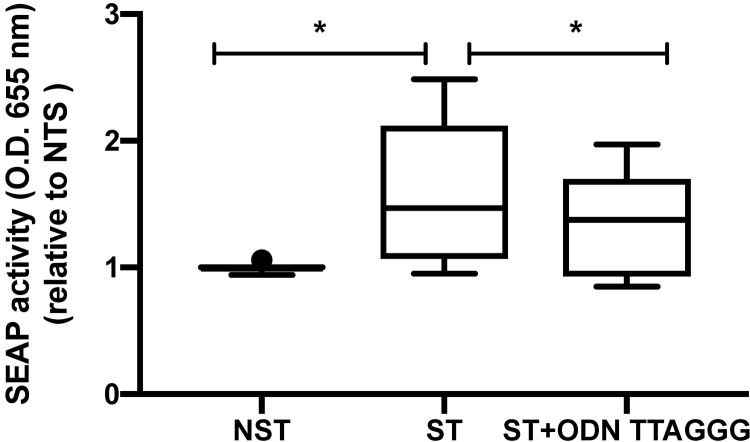
Supernatant from 24 hours stretched A549 cells induces TLR9 signaling that can be blocked with TLR9 antagonists.Supernatant collected from 24 hours stretched A549 cells and from unstretched cells were co-incubated with HEK-Blue hTLR9 reported cell line either alone or with TLR9 antagonists ODN TTAGGG. After 24 hours supernatants were analyzed for activity by spectroscopy of the target transgene NF-κB induced secreted embryonic alkaline phosphatase absorbance at 655 nm. Data are expressed as fold change over NST and represent median with interquartile range of at least three independent experiments. *P < 0.05, Mann-Whitney test (NST vs ST) and Wilcoxon signed-rank test (ST vs ST+ ODN TTAGGG) with FDR correction. NST: non stretch, ST: stretch.